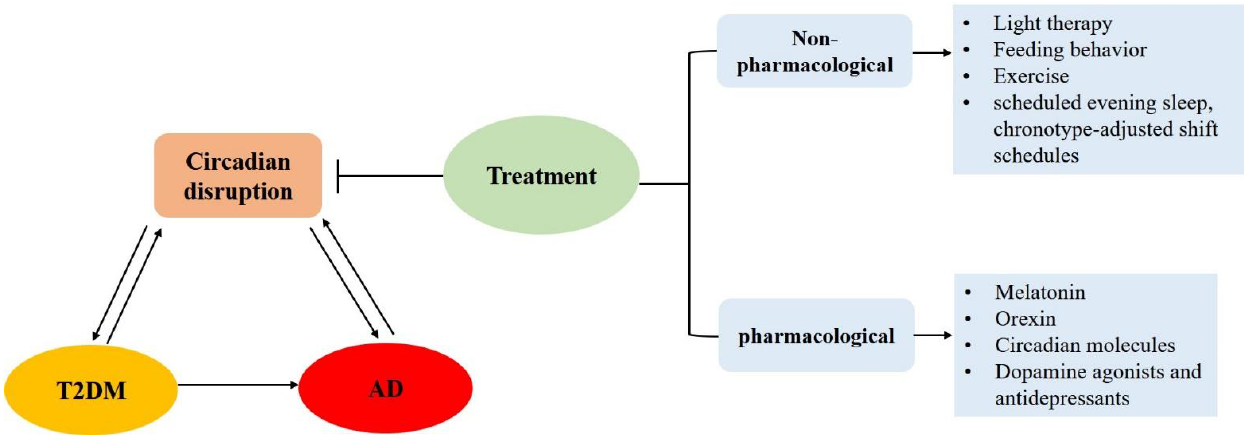
Figure 3. Promising therapeutic strategies targeting circadian disruption for T2DM and AD.